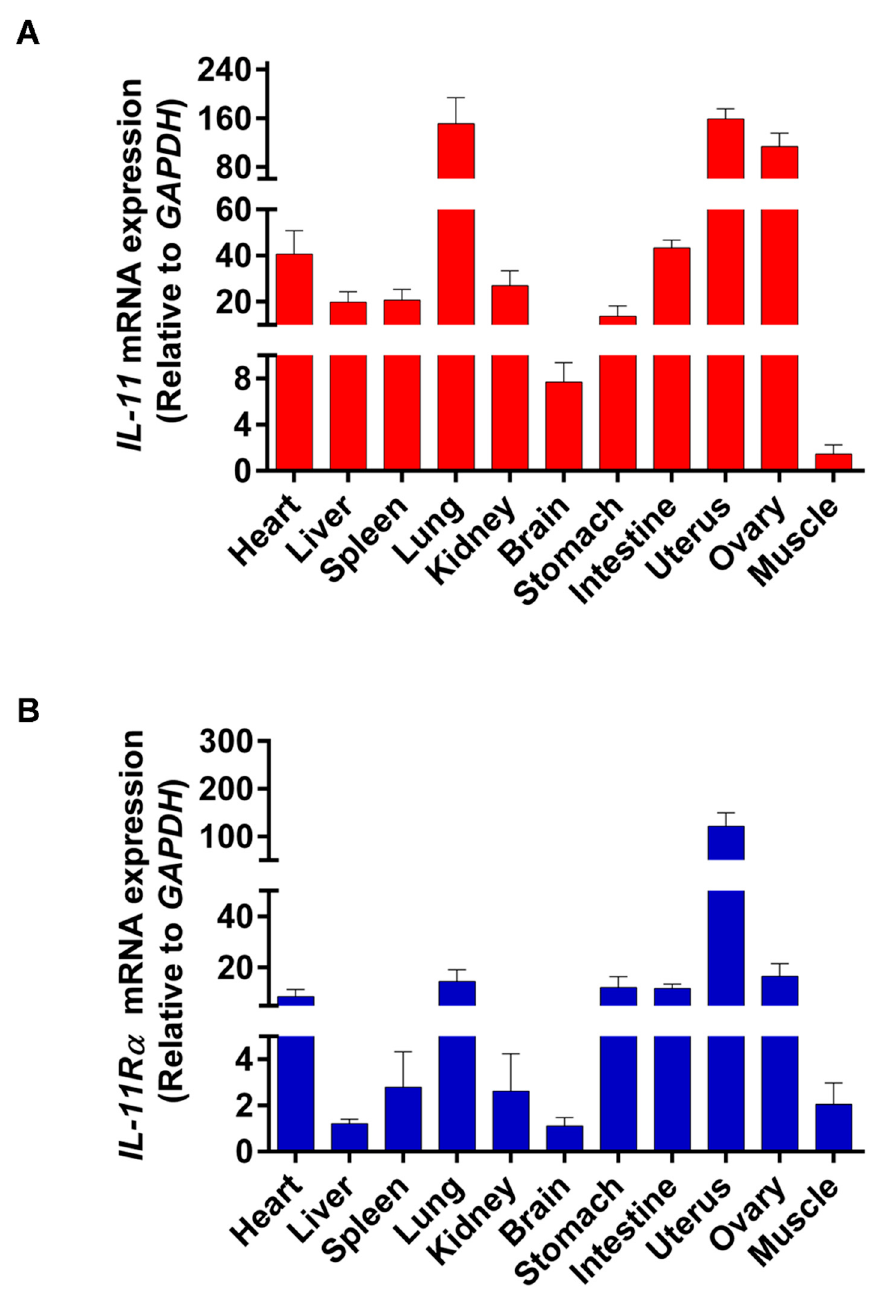
Figure 1. Tissue distribution of IL-11 and IL-11R α in bovine organs. ( A ) The relative mRNA expres- sion levels of IL-11 were quantitated in various tissues by qRT-PCR and normalized by GAPDH. The values are shown as the fold change above the muscle tissue (mean Cq value of the muscle is 27.46 and set to 1). ( B ) The relative mRNA expression levels of IL-11R α were quantitated in various tissues by qRT-PCR and normalized by GAPDH. The values are shown as the fold change above the brain tissue (mean Cq value of the brain is 23.60 and set to 1).